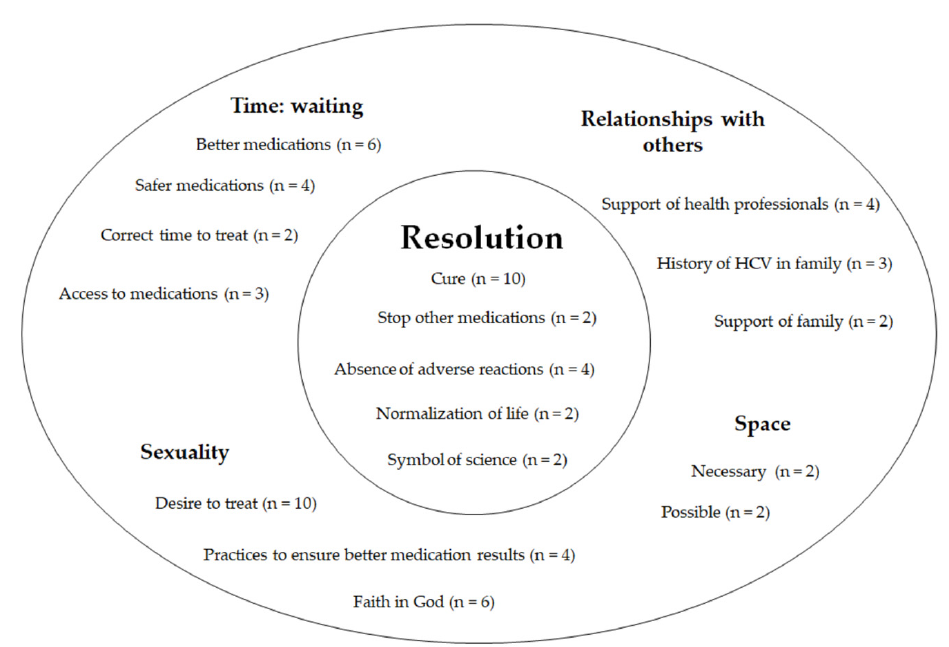
Figure 1. Ways of experiencing the use of DAAs and the essential structures of the experience: themes of the analysis and number of participants. (n = number of participants)